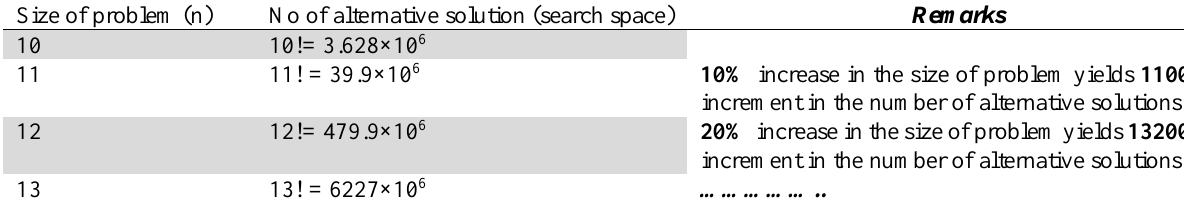
Abruptly increasing of search space in well-known operation research assignment problem Size of problem (n) No of alternative solution (search